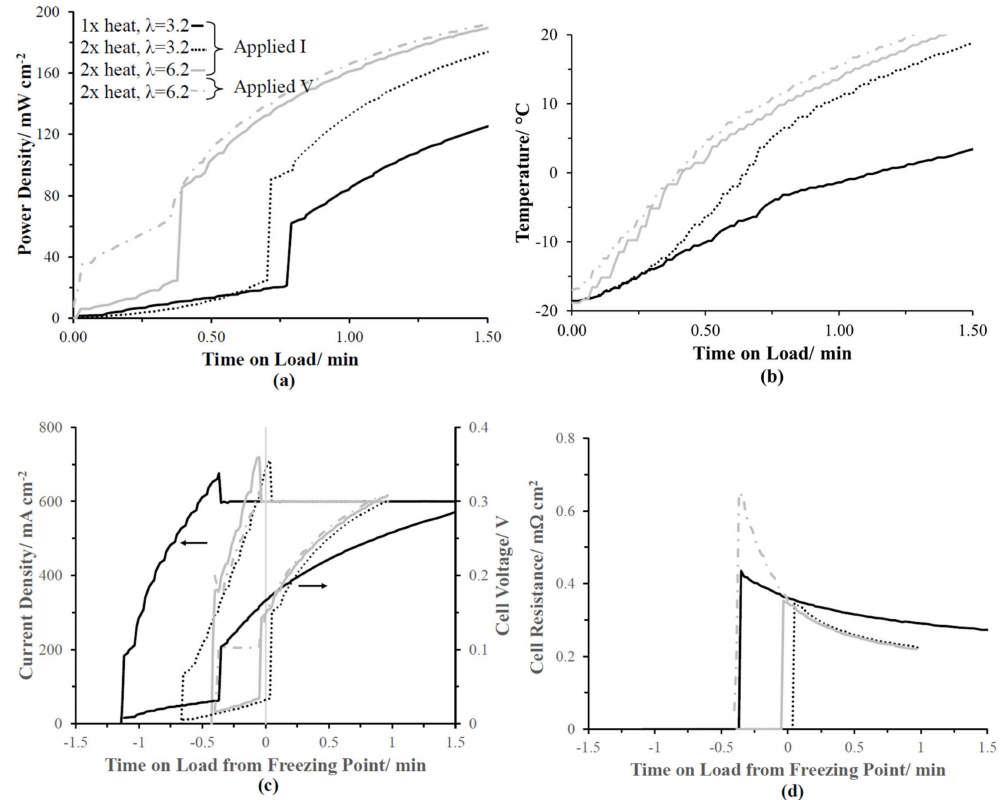
Figure 6. Preconditioned initial water content runs (3.2 and 6.2), cold-start tests under set galvanic load of 600 mA cm − 2 , or applied potentiostatic hold of 0.1 V at − 20 ◦ C and H 2 / 21% O 2 (0.5 / 0.75 lpm, respectively). ( a ) Power density and ( b ) cathode channel temperature versus time on load. ( c ) Current density and ( d ) cell resistance vs. time on load from 0 ◦